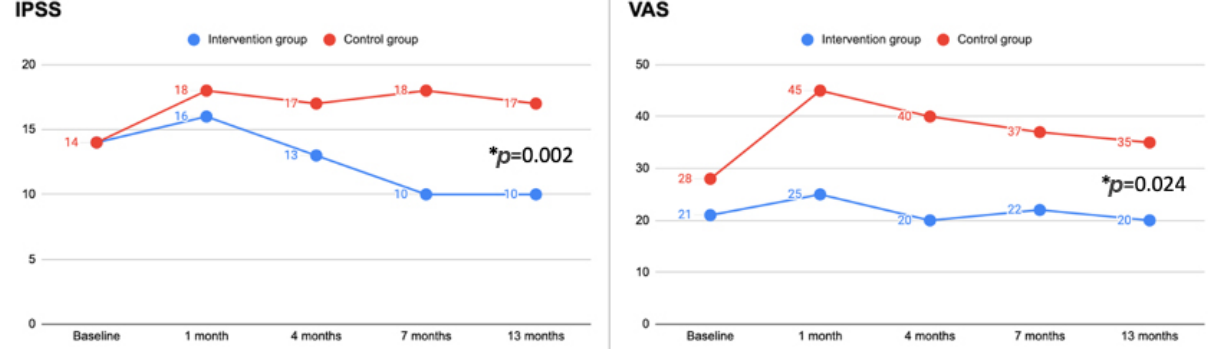
Figure 2. IPSS and VAS during the study period. All patients in both groups completed the scheduled visits (intervention group n = 15; control group n = 19). Values are reported as medians. IPSS: international prostate symptom score. VAS: visual analogue scale (0–100). * Referred to the last follow-up visit (13 months). Table 5. Local side effects of intravesical chemotherapy.